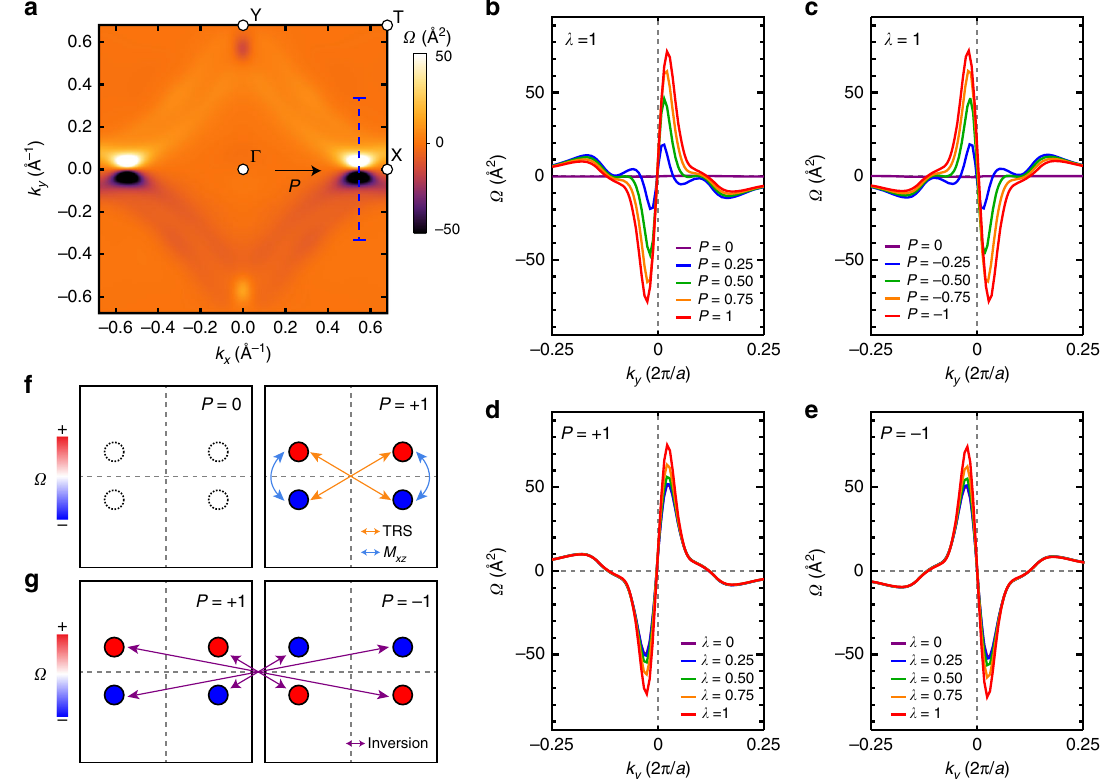
Fig. 2 Berry curvature ( Ω ) of the SnTe monolayer. a The calculated Berry curvature (BC) map in the fi rst Brillouin zone. The BC dipoles are formed at the X valleys. b – e The BC that is calculated along the vertical blue line in ( a ) under varying ( b , c ) ferroelectric polarization magnitude ( P ) and ( d , e ) spin – orbit coupling strength ( λ ), where the values of P and λ are normalized by the native values. The ferroelectricity reversal from ( b , d ) the positive to ( c , e ) the negative direction changes the sign of the BC distribution. These data imply that the BC dipole is strongly coupled with the ferroelectricity, rather than spin – orbit coupling. f Schematic drawings of the BC according to the symmetry of the system. The red and blue circles denote the two opposite signs. The zero BCs are enforced by the combination of the time-reversal symmetry and the inversion symmetry in the absence of the ferroelectricity. When the in- plane ferroelectricity develops, the positive and negative-BC peaks are formed along the k y . The peaks that are connected by orange (blue) arrows denote time-reversal (mirror-symmetric) pairs; they are transformed to each other by time-reversal (mirror) operation. g Schematic diagrams of the response of the BC to the ferroelectric switching. Since the + P and − P con fi gurations are inversion partners, the BCs of two con fi gurations are opposite at the same k point. The points that are connected by purple arrows denote inversion